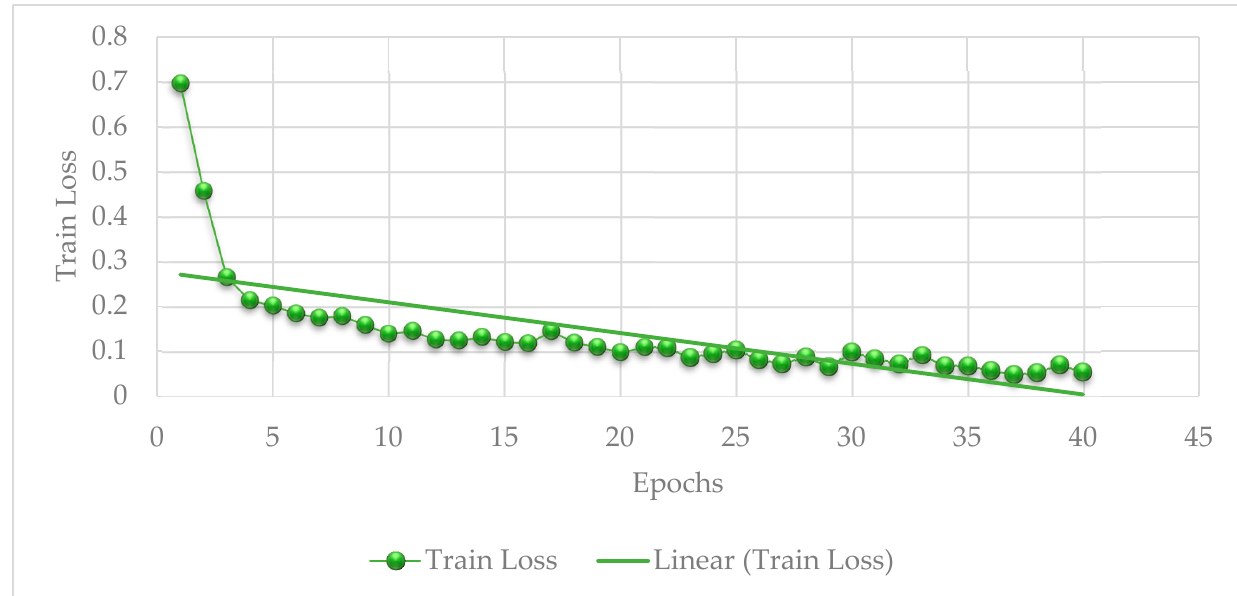
Figure 9. Graph showing train loss vs. epoch characteristics.